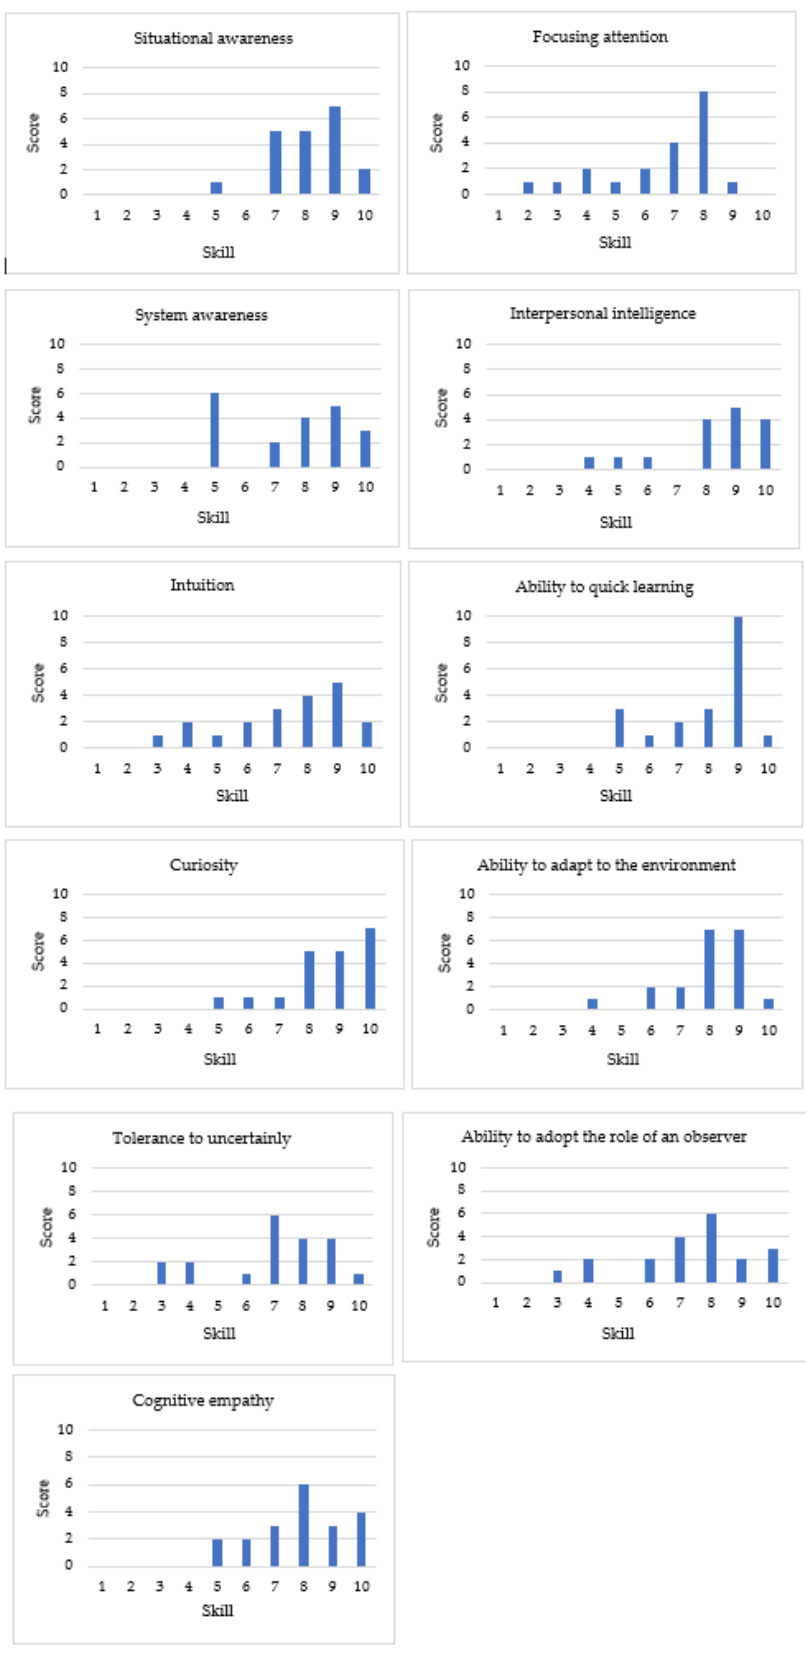
Figure 4. Analysis of managers’ behaviors and skills. The respondents indicated curiosity (seven responses), interpersonal intelligence (four responses) and cognitive empathy (four responses) on a scale of 10 out of 10 possible points as the most developed skill. The ability to learn quickly (10 responses), situational awareness (seven responses) and the ability to adapt to the changing environment (seven responses) on a 9 out of 10 scale were also rated highly. The respondents assigned less